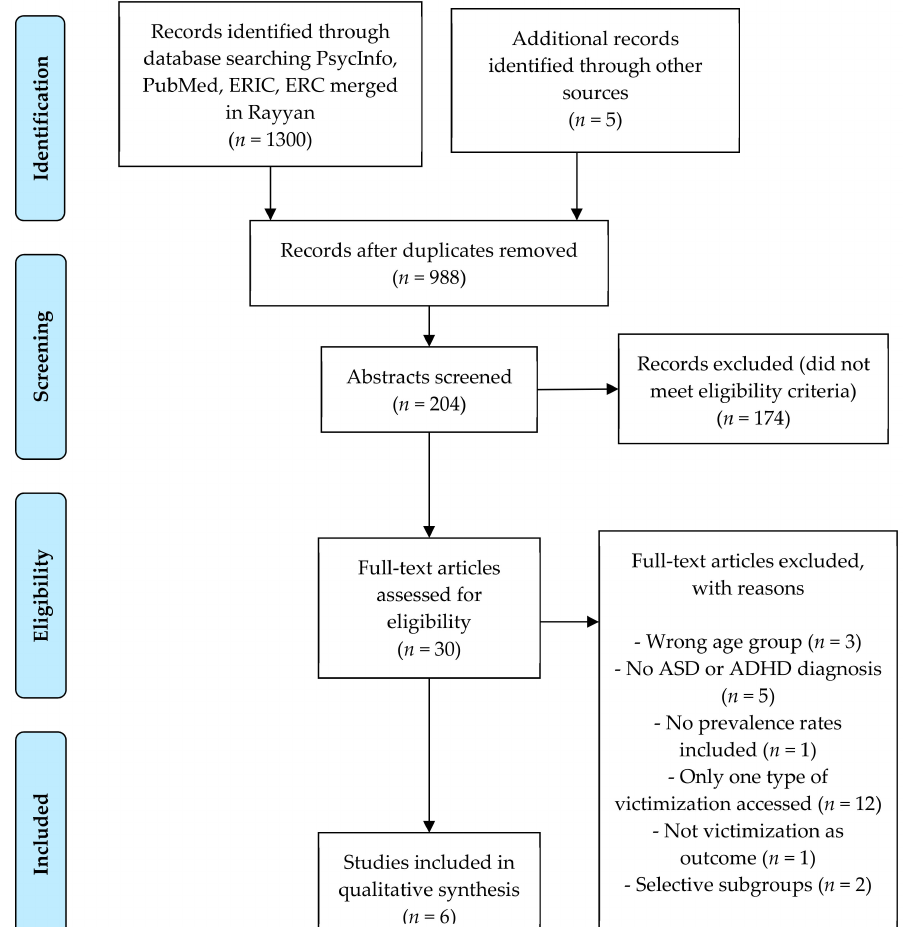
Figure 1. Flow chart diagram showing the process of study